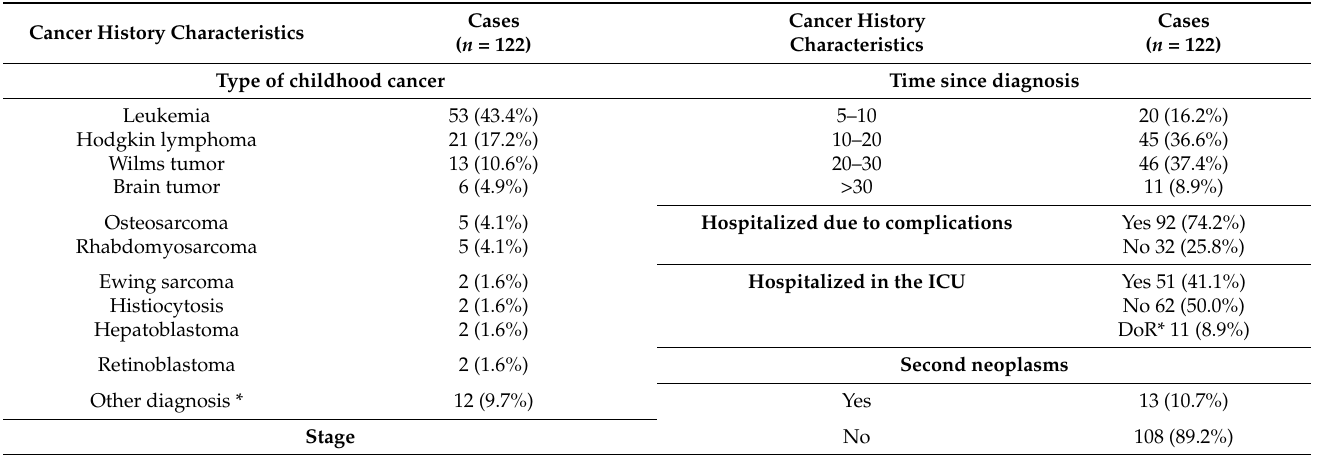
Table 2. Cancer history characteristics of Colombian